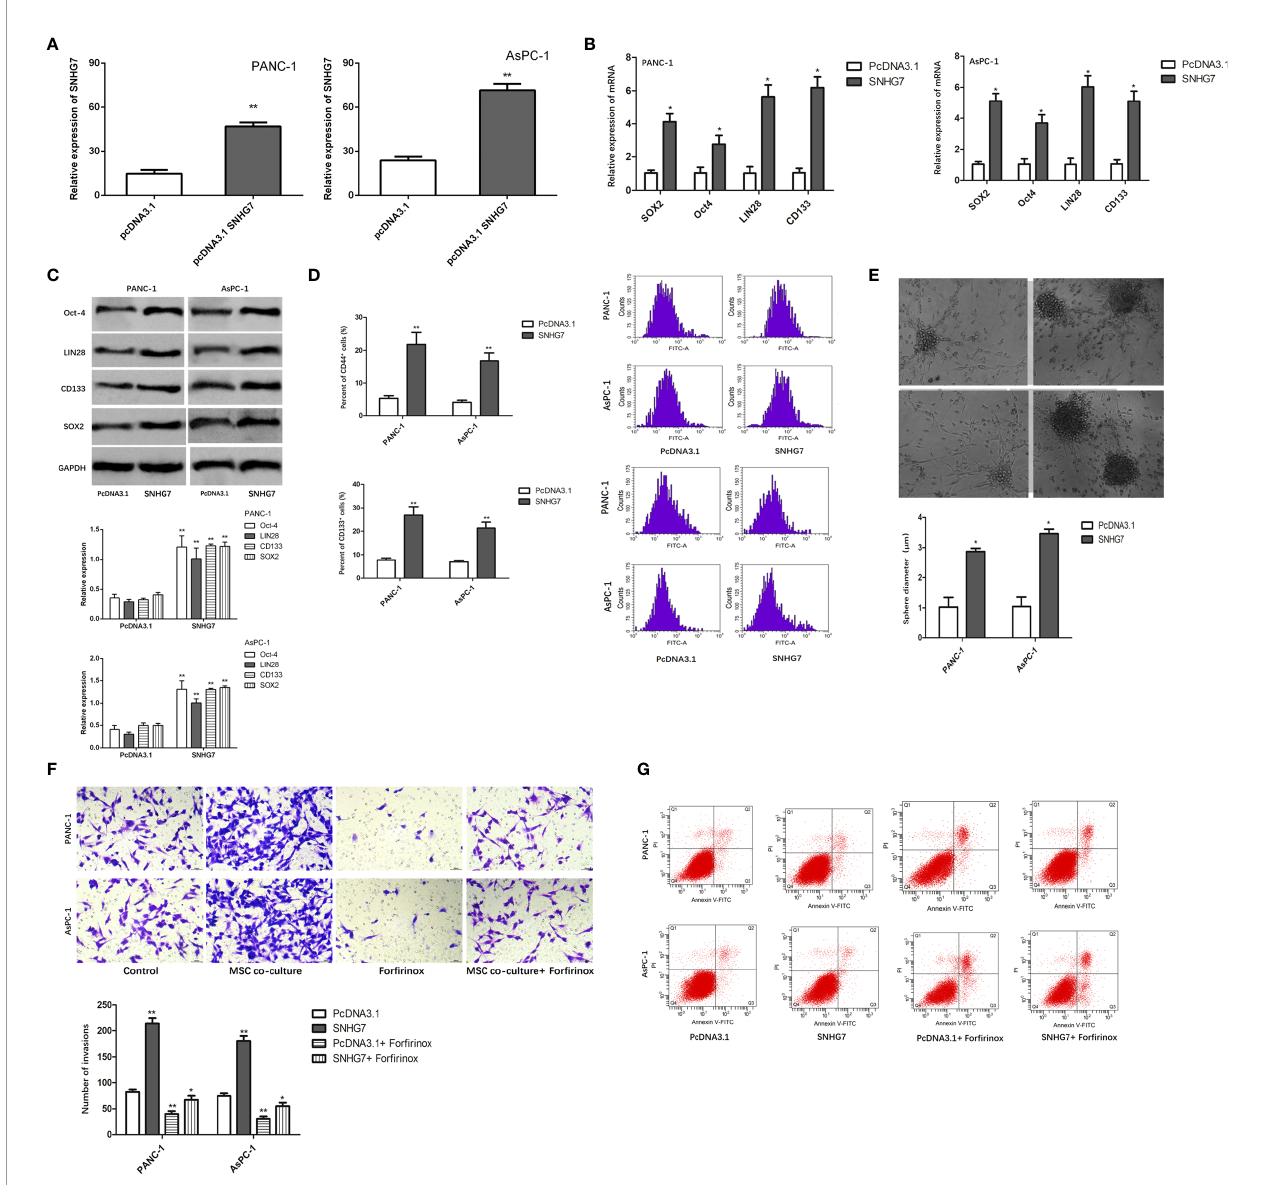
FIGURE 4 | The effect of SNHG7 on the stemness and Fol fi rinox resistance. (A, B) overexpression ef fi ciency was examined was veri fi ed by RT-qPCR and Western blot analyses. (C) Western blotting for stemness-associating genes in PANC-1 and AsPC-1 cell culture either alone or with MSCs and with or without Fol fi rinox. (D) The proportion of CD44 + pancreatic cancer cells. (E) Sphere-formation assay in PANC-1 and AsPC-1 cell culture either alone or with MSCs and with or without Fol fi rinox. (F, G) Colony-formation assay and fl ow cytometric analysis of PANC-1 and AsPC-1 cell culture either alone or with MSCs and with or without Fol fi rinox. *P < 0.05, **P <